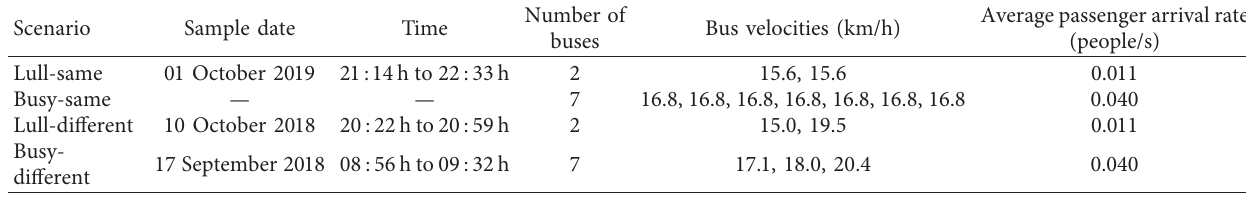
Table 3: Four test scenarios of the intervention strategies. The scenarios lull-same , lull-different , and busy-same are sets of empirical trajectories sampled on the stated date and time, while the busy-same is a hypothetical variant of the busy-different scenario with all 7 buses having the same